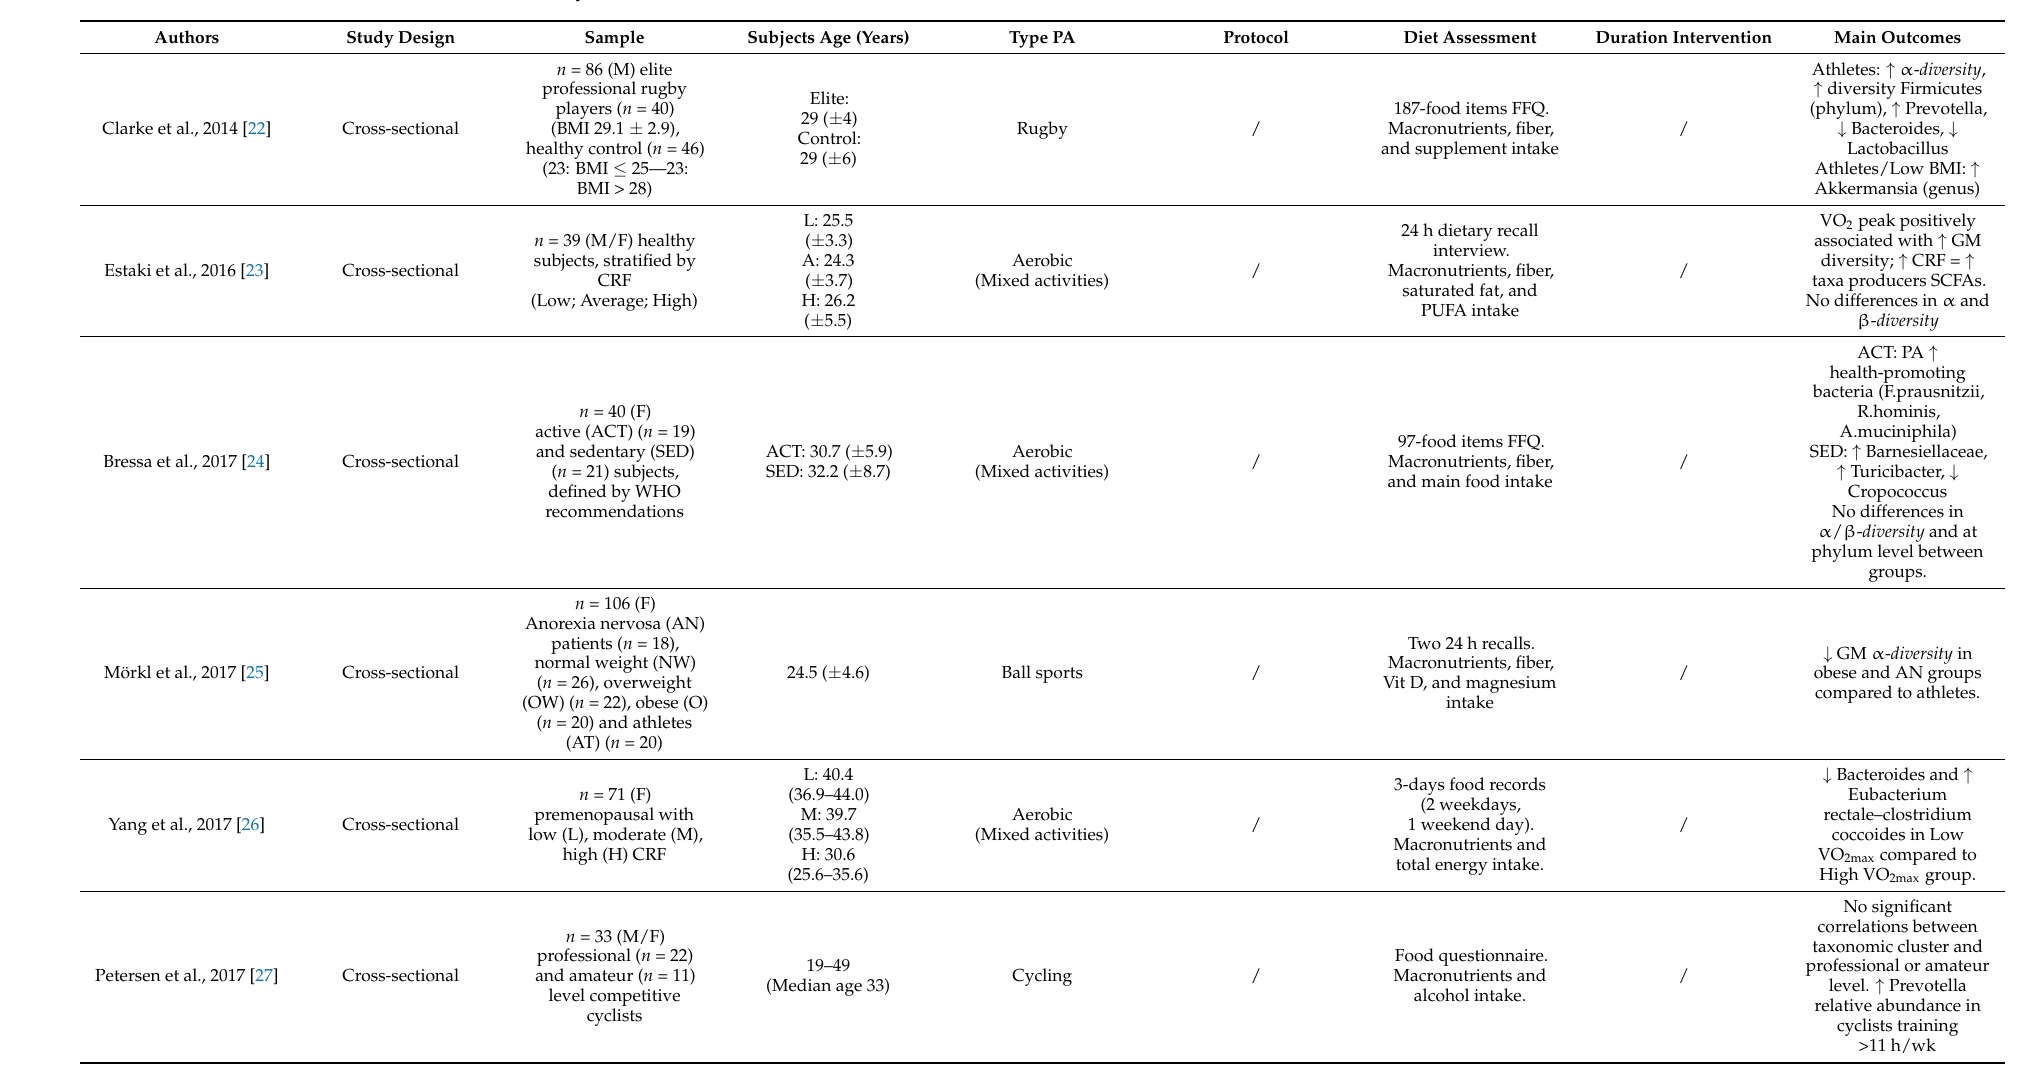
Table 1. Summary characteristics of reviewed human